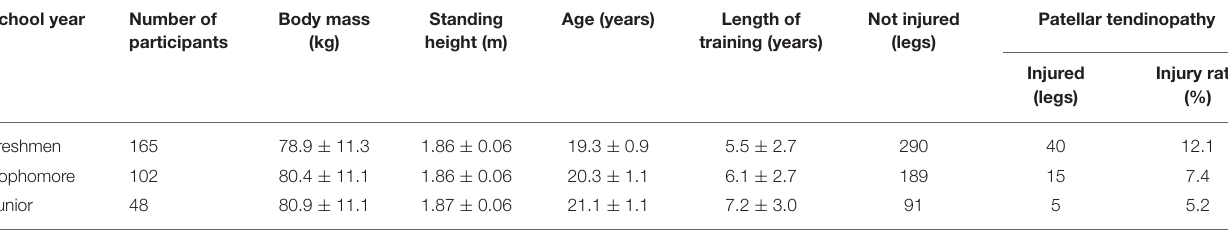
TABLE 2 | Characteristics of participants included in data analysis in each school year.